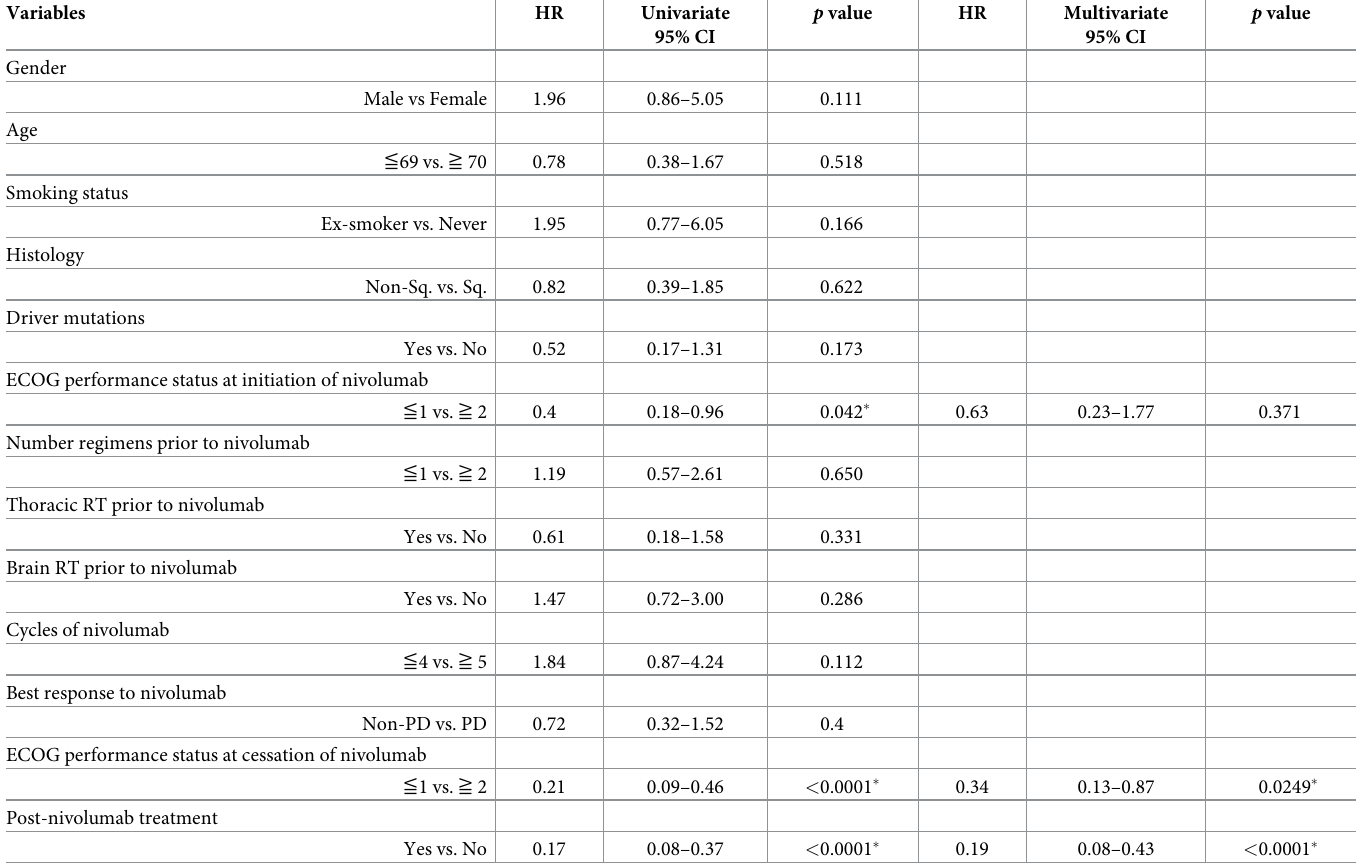
Table 5. Univariate and multivariate analyses of clinical factors influencing PPS after cessation of